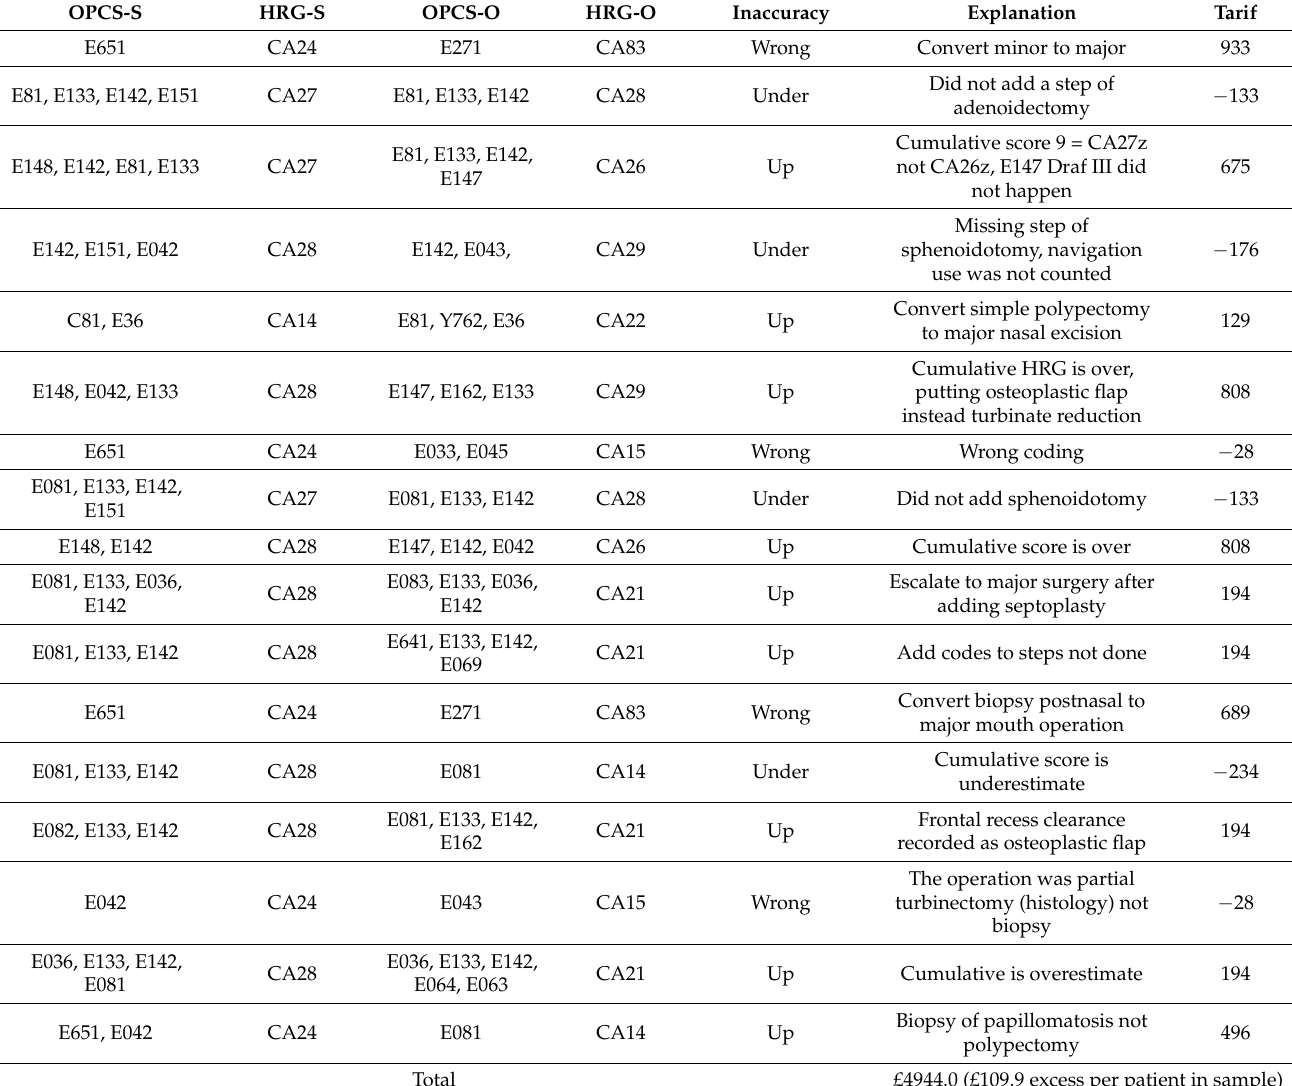
Table 2. Summary of patients from cycle one with inaccurate Health Resource Group (HRG) coding and tariff payments with associated reasons for